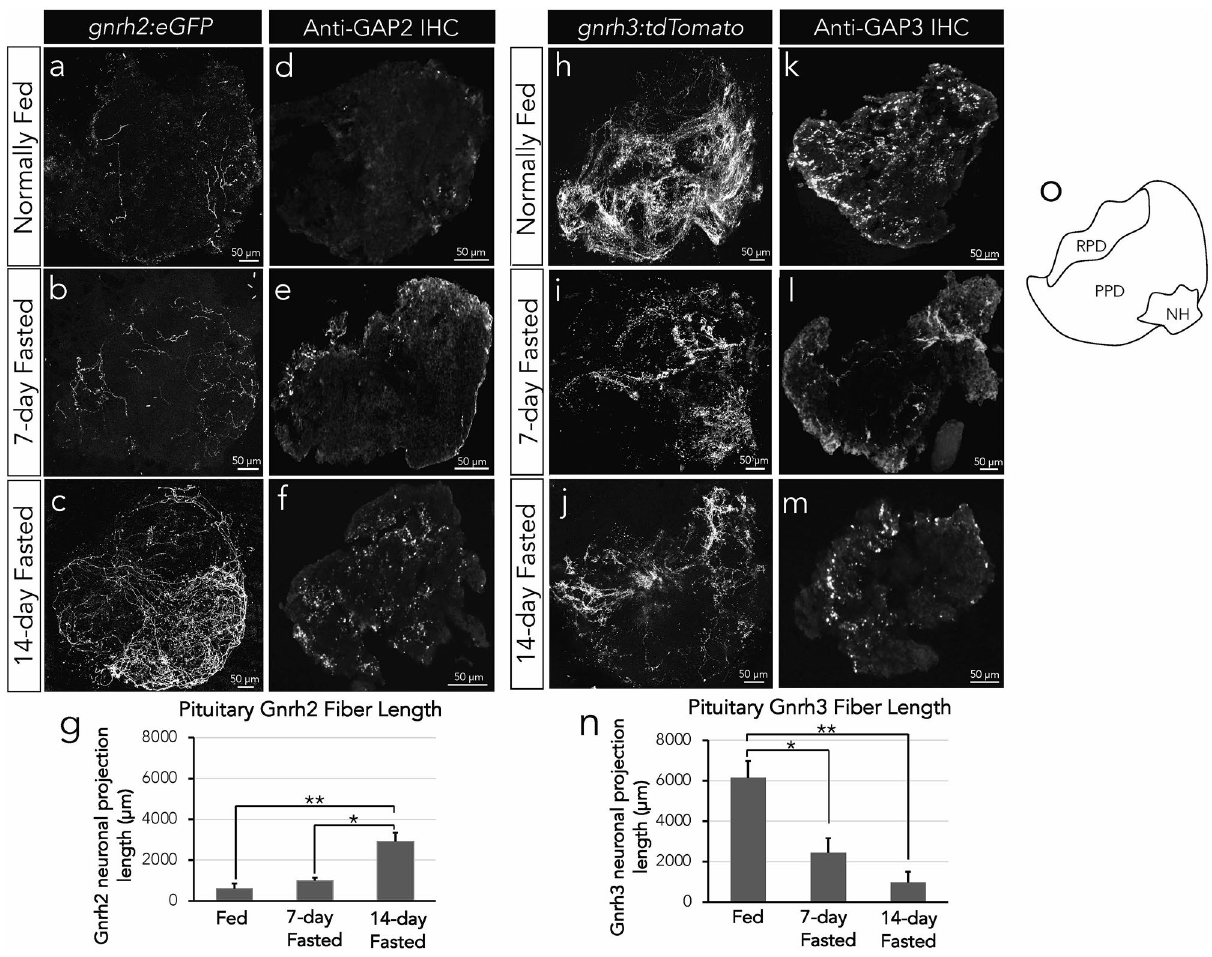
Figure 1. Confocal imagery of tg(gnrh2:eGFP) pituitaries in normally fed (a), 7-day fasted (b) and 14-day fasted (c) conditions. Antibody staining of the specific GAP2 region of Gnrh2 in pituitary cryosections of fed (d), 7-day fasted (e), and 14-day fasted zebrafish (d) with the quantification of Gnrh2 neuronal fiber lengths confirming increased Gnrh2 in 14-day fasted conditions (e). Confocal imagery of tg(gnrh3:tdTomato) pituitaries in normally fed (f) and 14-day fasted (h) conditions. Immunohistochemistry antibody staining of the specific GAP3 region of Gnrh3 in pituitary cryosections of fed (g) and 14-day fasted zebrafish (i) with the quantification of Gnrh3 neuronal fiber lengths confirming decreased Gnrh3 in 14-day fasted conditions (j). Pictoral representation of the pituitary orientation of images shown (k). NH, neurohypophysis; PPD, proximal pars distalis; RPD; rostral pars distalis. All data expressed as means ± S.E.M, n = 6 pituitaries per group, **P < 0.01, *P <